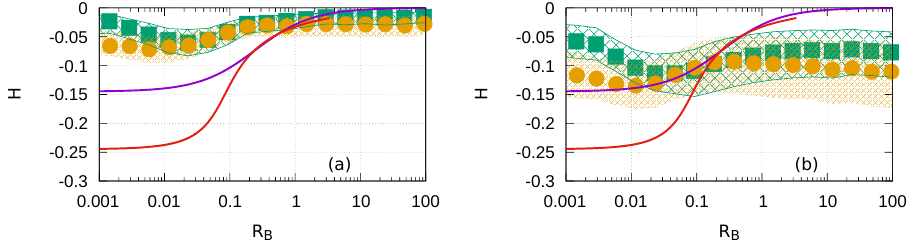
Figure 5. Normalized vertical heat flux H = (cid:104) w θ (cid:105) / [ E K (cid:104) θ 2 (cid:105) ] 1/2 as function of R B : ( a ) 30 min averages; and ( b ) 2 min averages. Symbols, colors and lines are the same as in Figures 1a and 4.